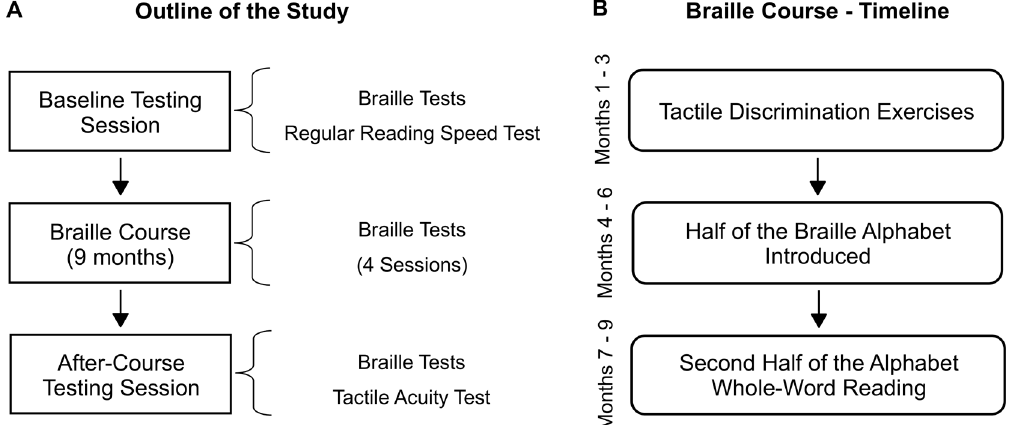
Fig 1. Outline of the study and timeline of the braille course. (A) Sighted adults underwent a 9-month braille course. They were tested behaviorally in the baseline testing session, four times during the course (i.e., in the 5 th , 6 th , 7 th and 8 th month of the course) and after the course. (B) The braille course consisted of three stages: tactile discrimination exercises, introducing half of the braille alphabet and learning the remaining half/whole-word